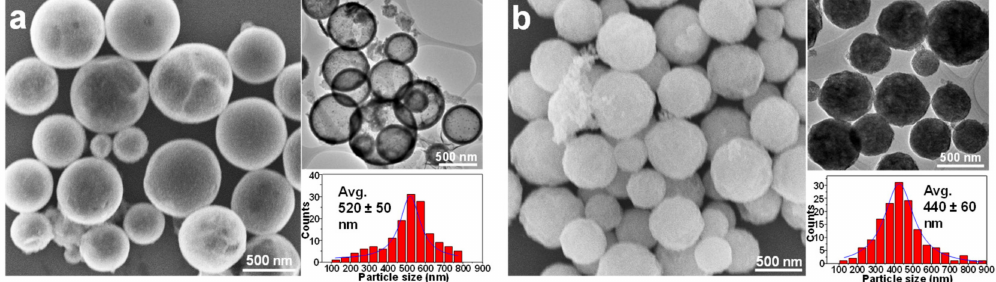
Figure 2. Morphologies of Silica-dye microspheres synthesized at ( a ) 150 ◦ C and ( b ) 300 ◦ C, with the particle size of 520 ± 50 nm and 440 ± 60 nm,